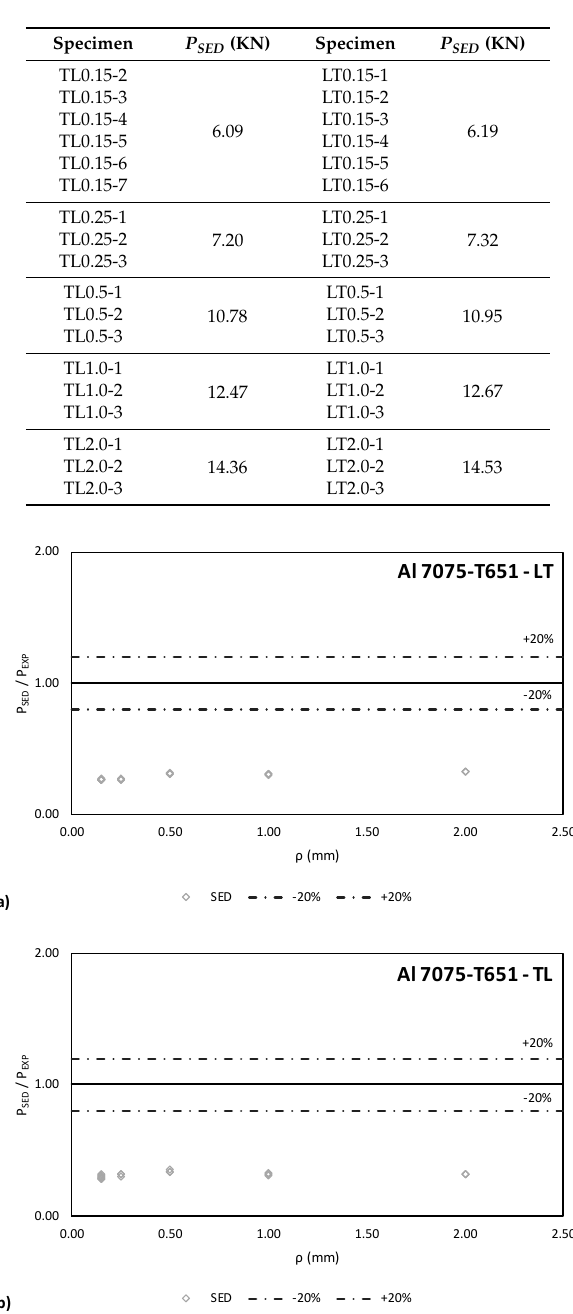
Table 6. SED fracture loads for TL and LT specimens.